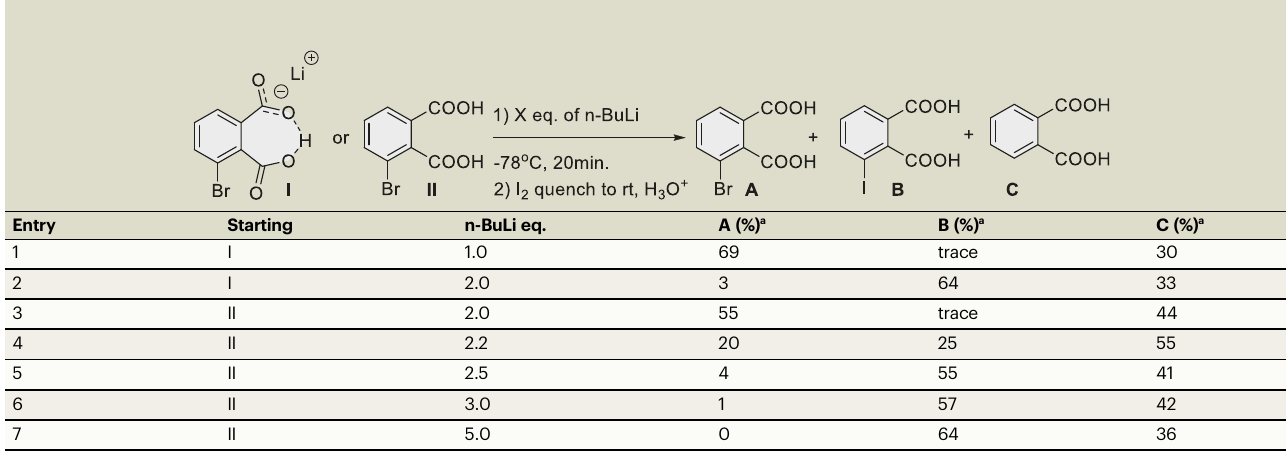
Table 1 | Optimization of the Li-halogen exchange reaction conditions of 3-bromophthalic acid